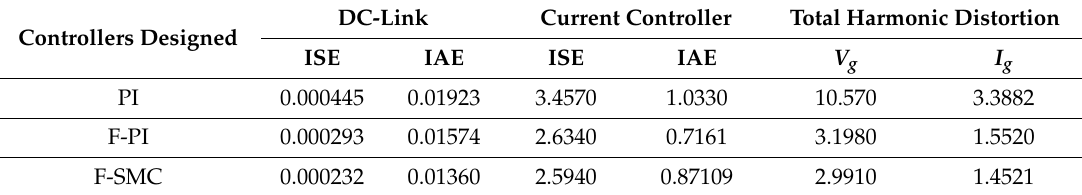
Table 4. Performance of the designed controllers with feed-forward loop of PV